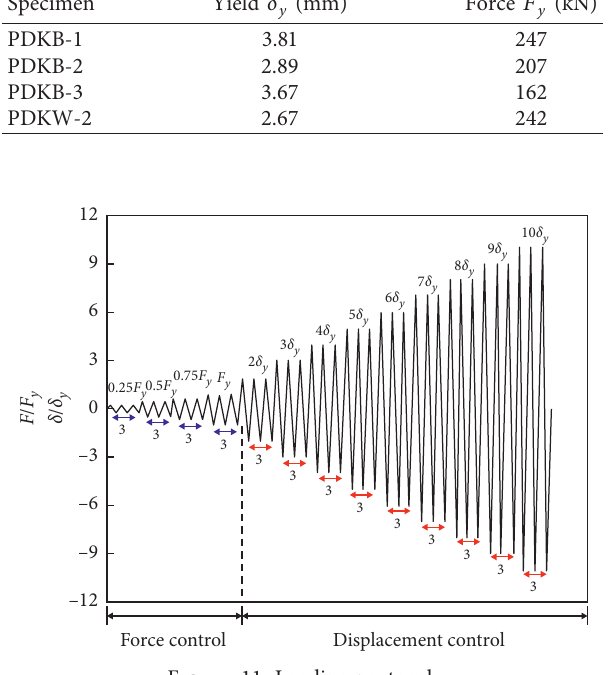
Figure 11: Loading